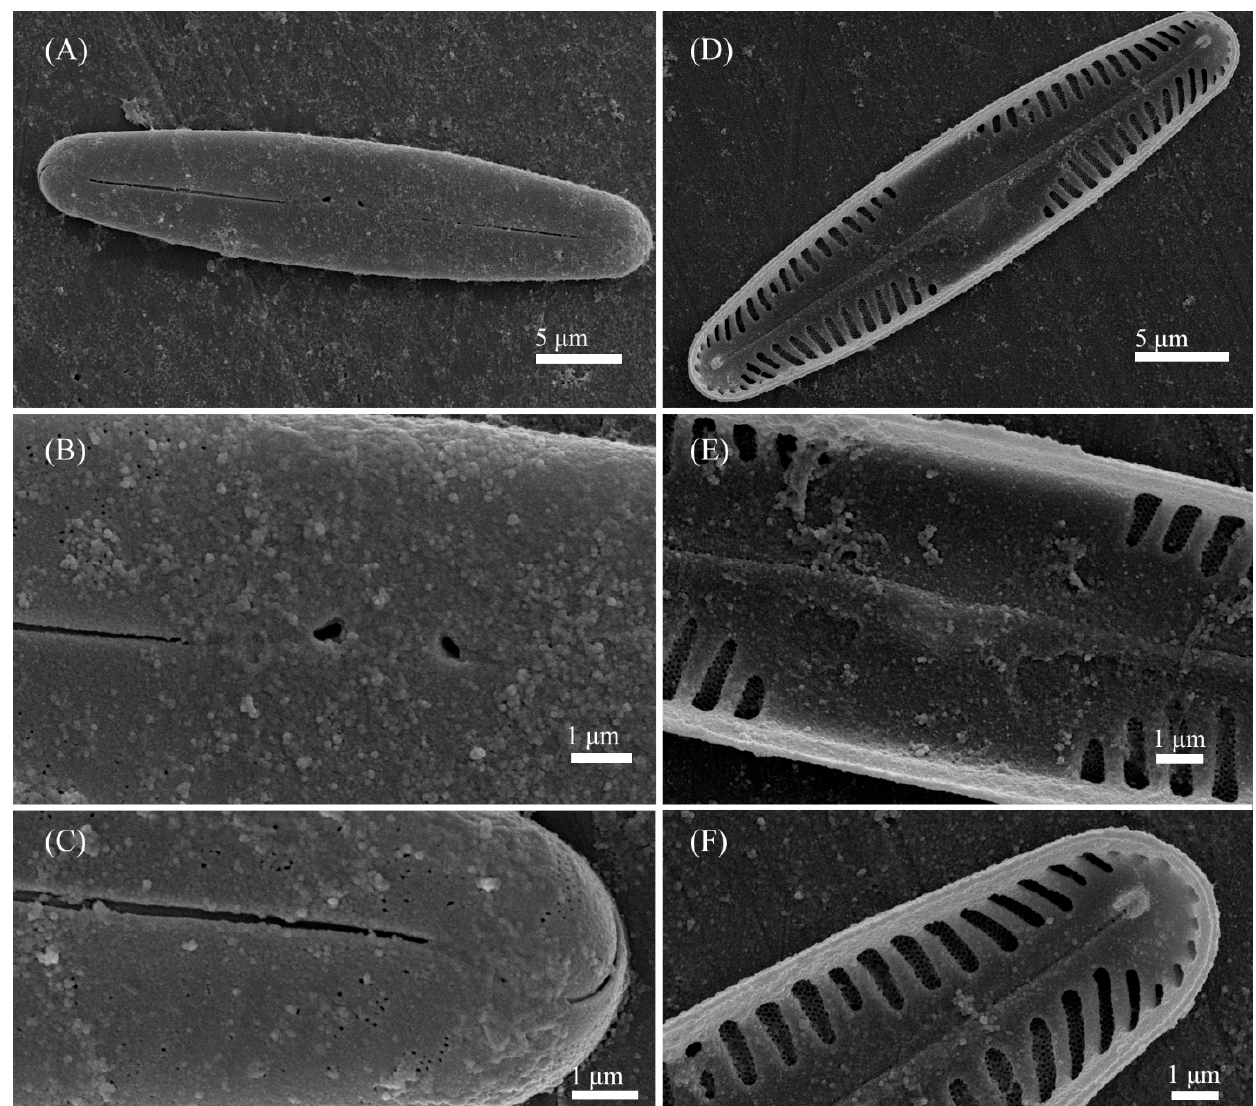
Figure 6. Pinnularia vietnamogibba Kezlya, Maltsev, Krivova & Kulikovskiy sp. nov. Strain VP294 sample No. 07052. Scanning electron microscopy. ( A – C ) External views. ( D – F ) Internal views. ( A , D ) The whole valve. ( B , E ) Central area. ( C , F ) Valves ends. Arrows indicate the ghost striae.